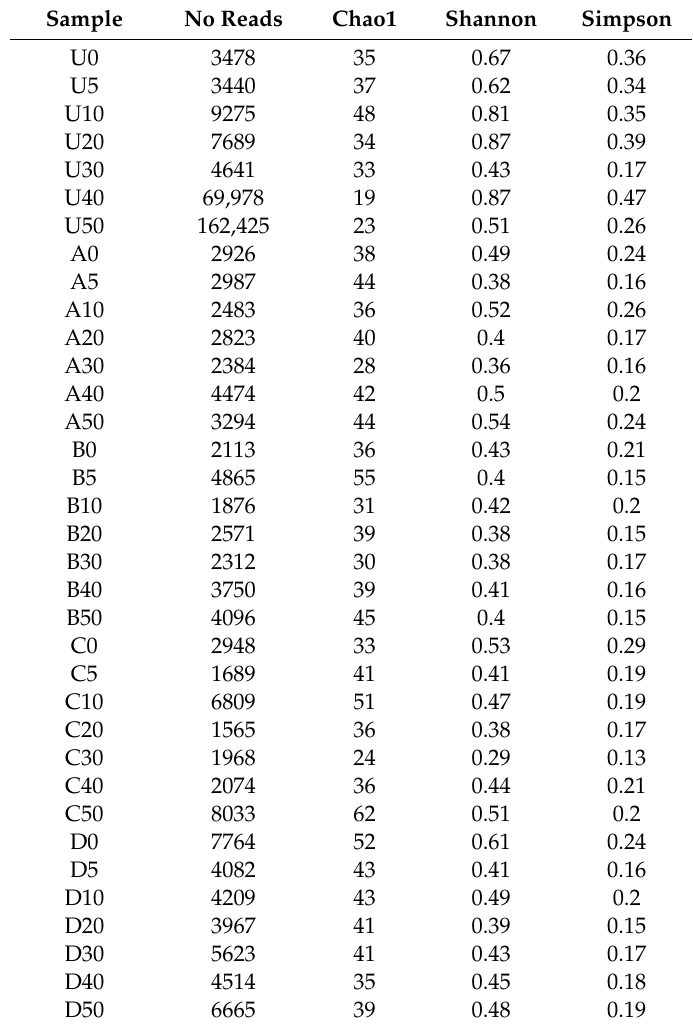
Table 3. No. of reads and alpha diversity indexes at genus level of guacamole samples treated or not by high-hydrostatic pressure